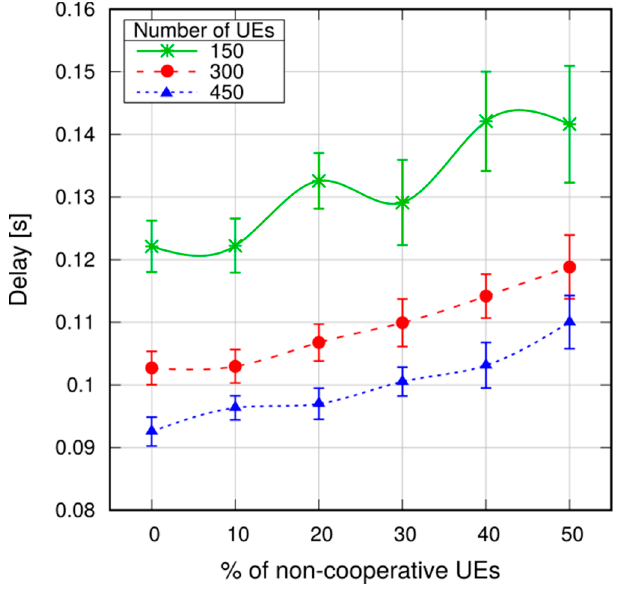
Figure 24. 95th percentile of delay with non-cooperative UEs.